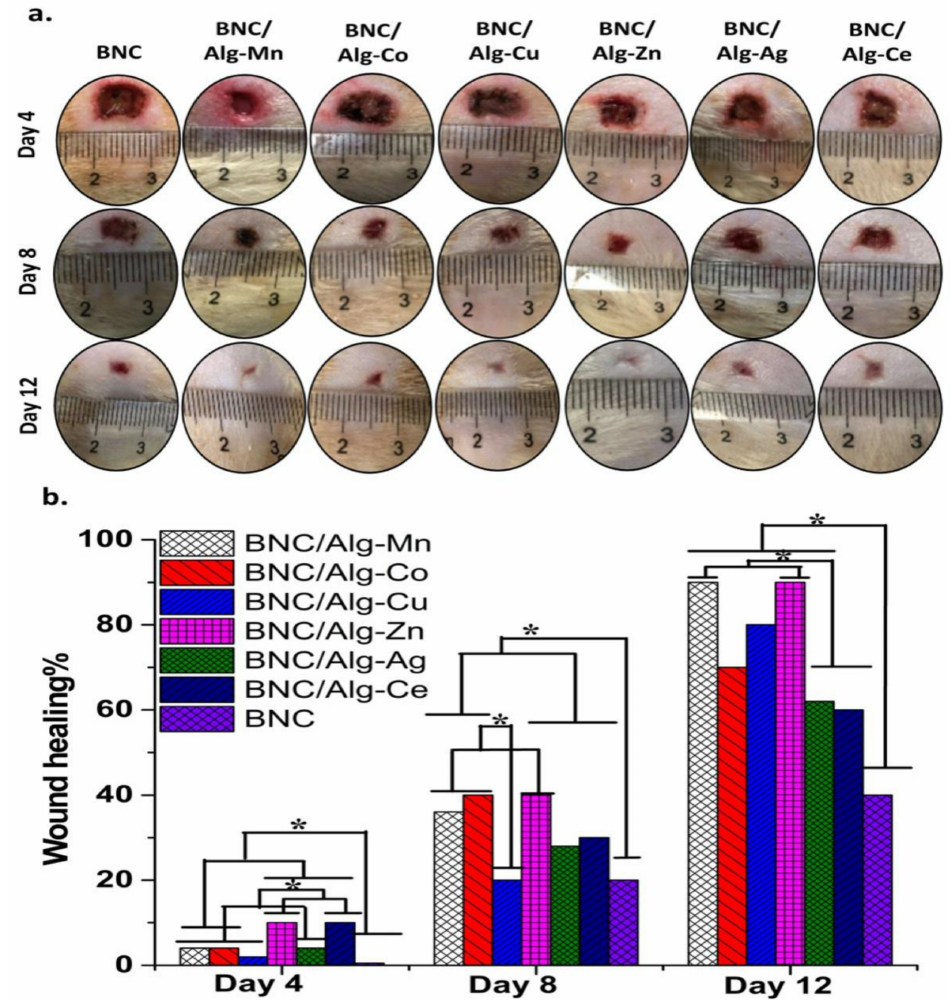
Figure 7. In vivo wound healing performance of the synthesized dressing materials. ( a ) Photographs of wound size during healing at 4th, 8th, and 12th day for synthesized dressing materials. ( b ) The wound healing ability of di ff erent cation cross-linked Alg / BNC composites. * p < 0.05 using Student’s t -test